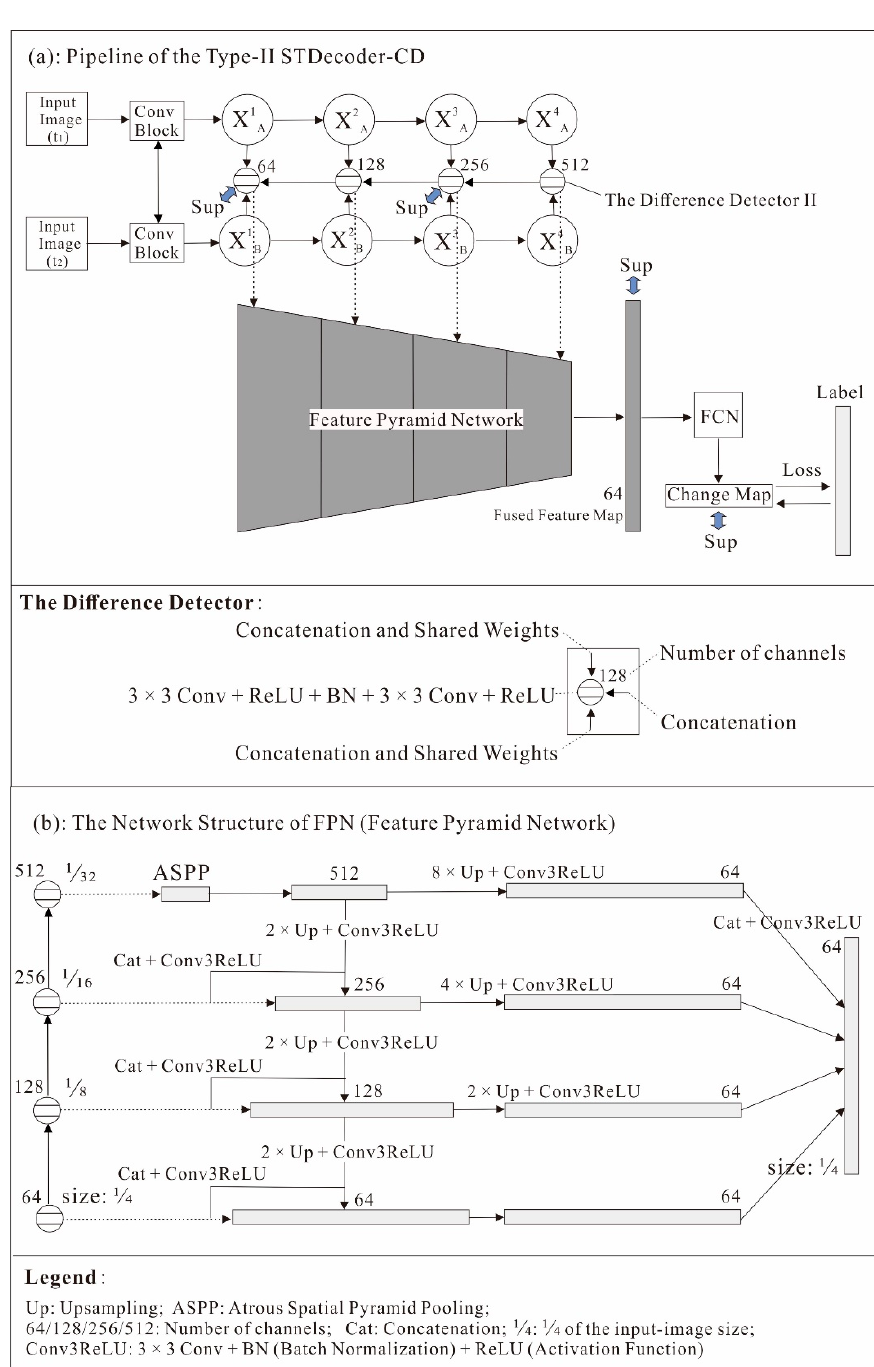
Figure 3. Flowchart of the Type II STDecoder ‐ CD architecture. The legends in this figure are con ‐ sistent with those in Figures 1 and 2 if not